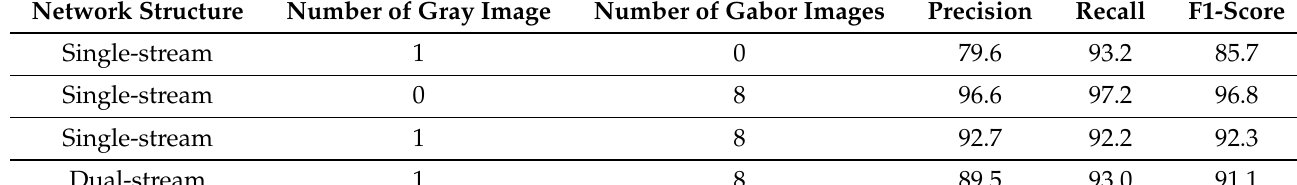
Table 6. Performance of proposed method on compact camera module dataset.